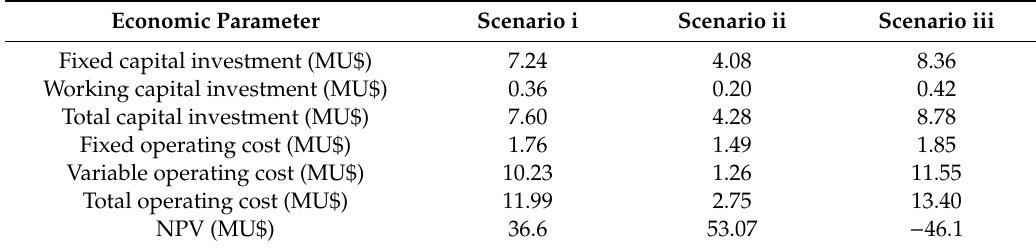
Table 7. Outcome of the economic